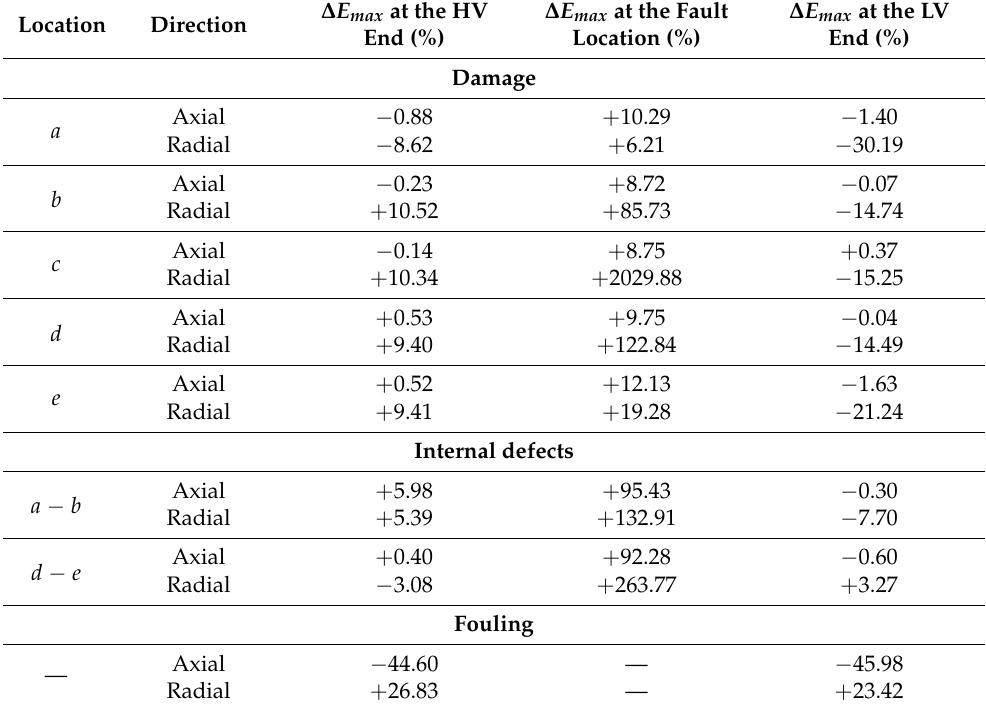
Table 5. Difference in the axial and radial electric fields between normal composite insulators and faulty composite